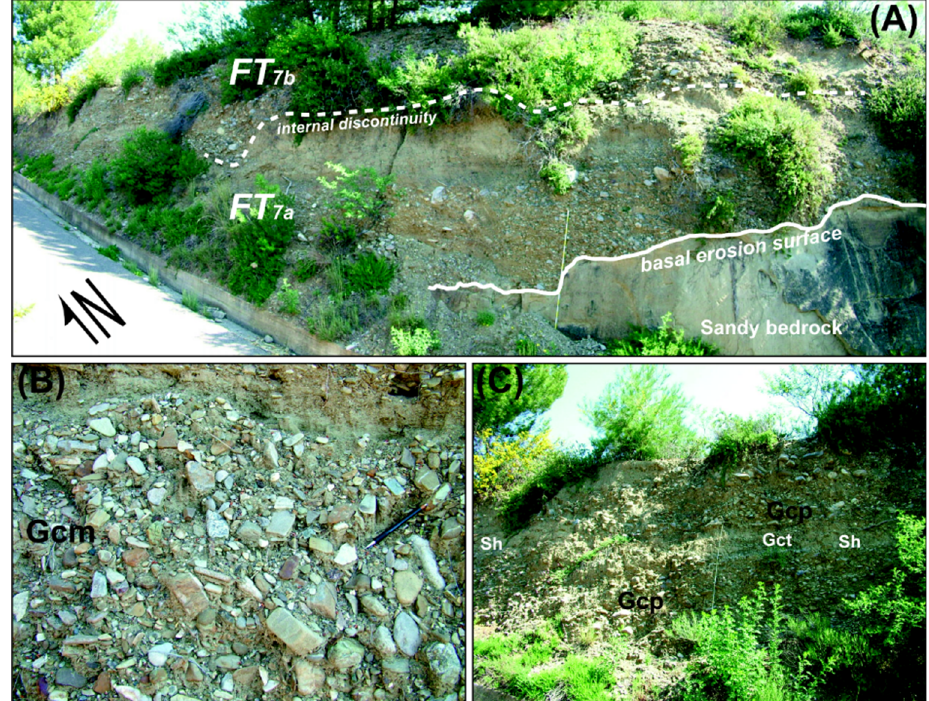
Figure 9. View of the two sedimentary sequences forming the S. Teodoro unit, close to the Tursi Village ( A ). Detail of the sub-angular pebbles assigned to the Gcm facies ( B ) and crops out of the FT 7b depositional sequence ( C ). See Table 1 for facies code and interpretation.